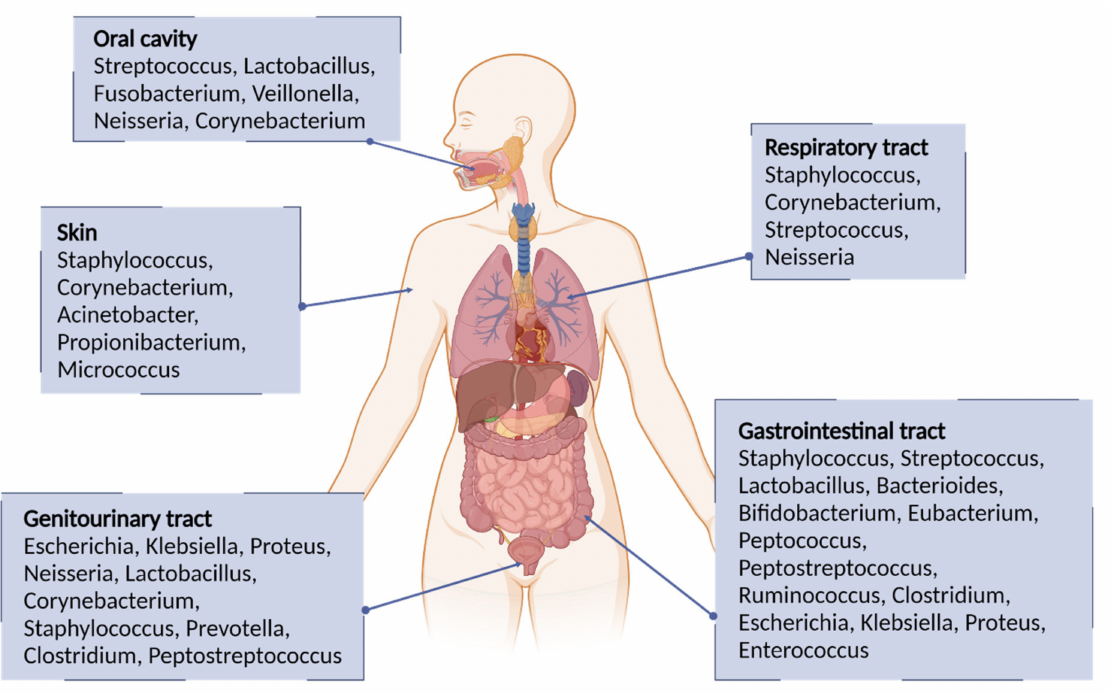
Figure 1. Schematic representation of target human districts of the main gram-positive and gram- negative bacteria. Created with BioRender.com (Accessed on 29 April